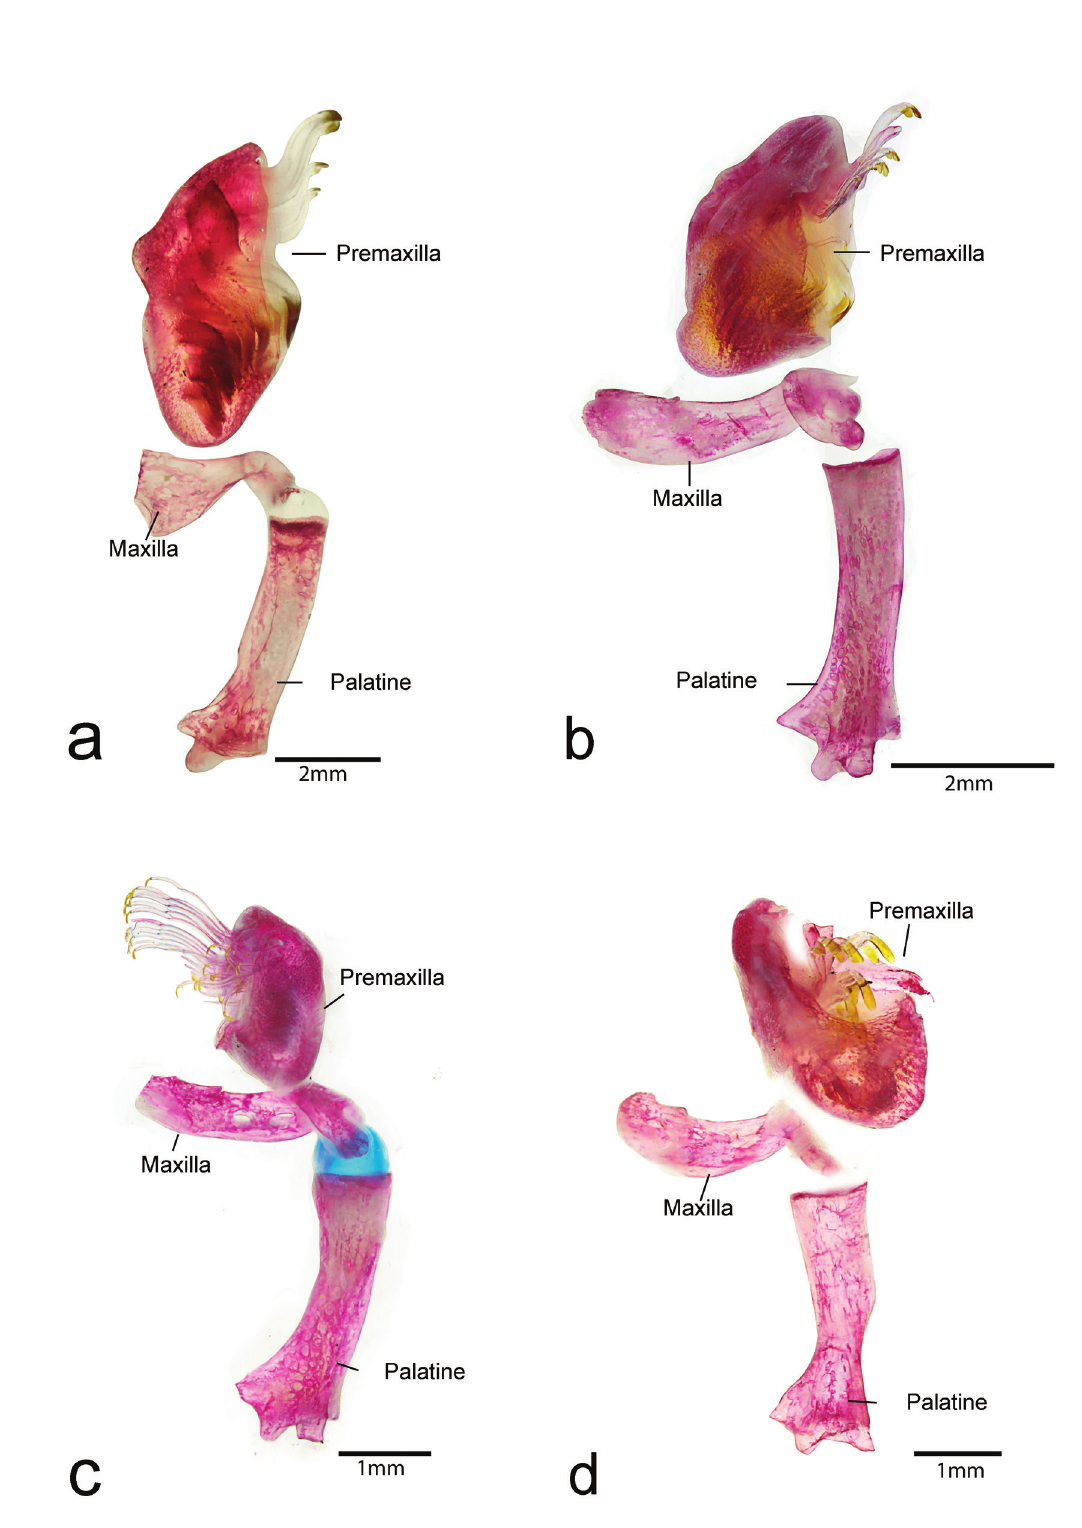
Fig. 3. Palatine, maxillar, and premaxillar in (a) Spectracanthicus murinus , MZUSP 24293, 37.0 mm SL, (b) Spectracanthicus zuanoni , INPA 3957, 57.0 mm SL, (c) Spectracanthicus immaculatus , paratype, MZUSP 92617, 58.9 mm SL and (d) Spectracanthicus tocantinensis , paratype, MZUSP 34265, 65.4 mm